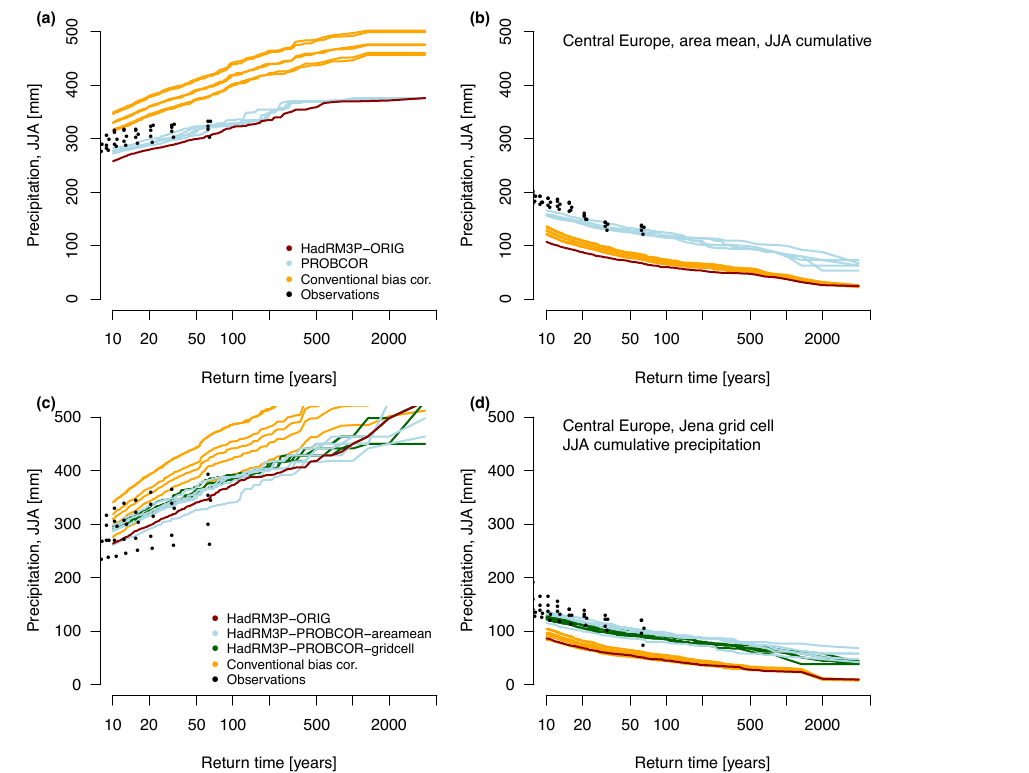
Figure 5. Return times of wet (a, c) and dry (c, d) rainfall extremes in summer (JJA) in the original regional model simulations (“ORIG”), in the resampled ensemble (“PROBCOR”) and the mean-adjusted ensemble (“ISIMIP”). Plots are shown as spatial averages over Central Europe (top panels) and for an illustrative grid cell (“Jena pixel”, bottom panels). Black dots in each plot indicate empirical return times estimated from observations taken from seven different data sets that were used for bias correction.